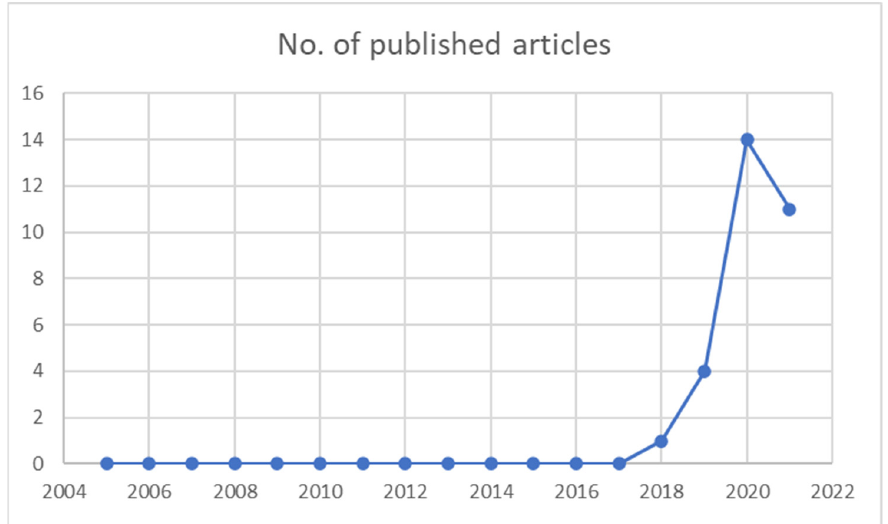
Figure 2. Articles distribution based on the publication year.